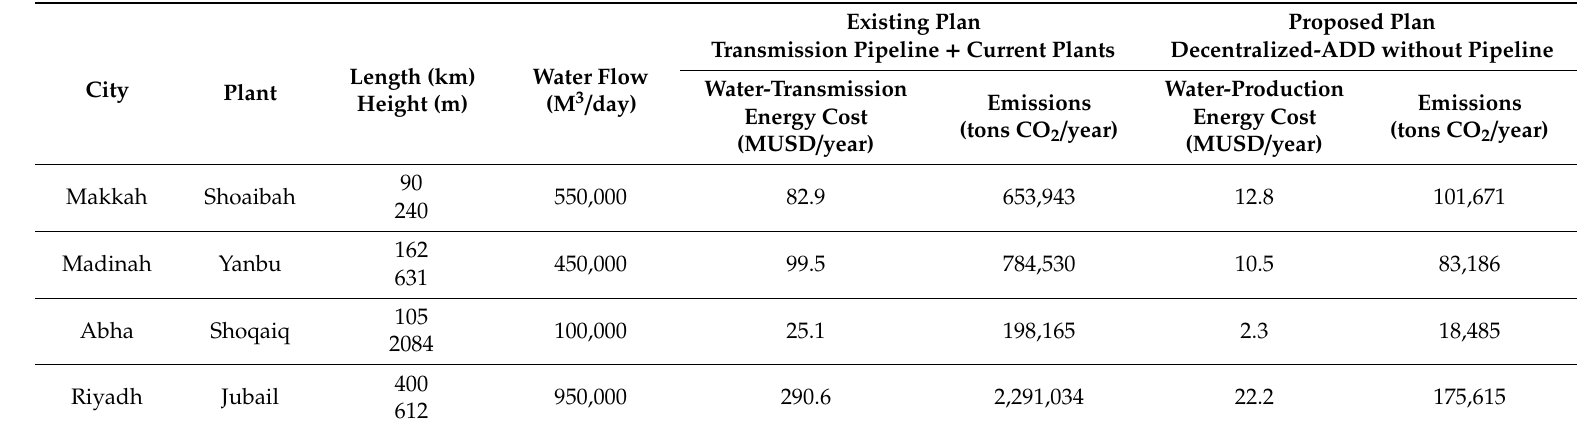
Table 1. Impact of new technologies and decentralization on energy consumption and CO 2 emissions